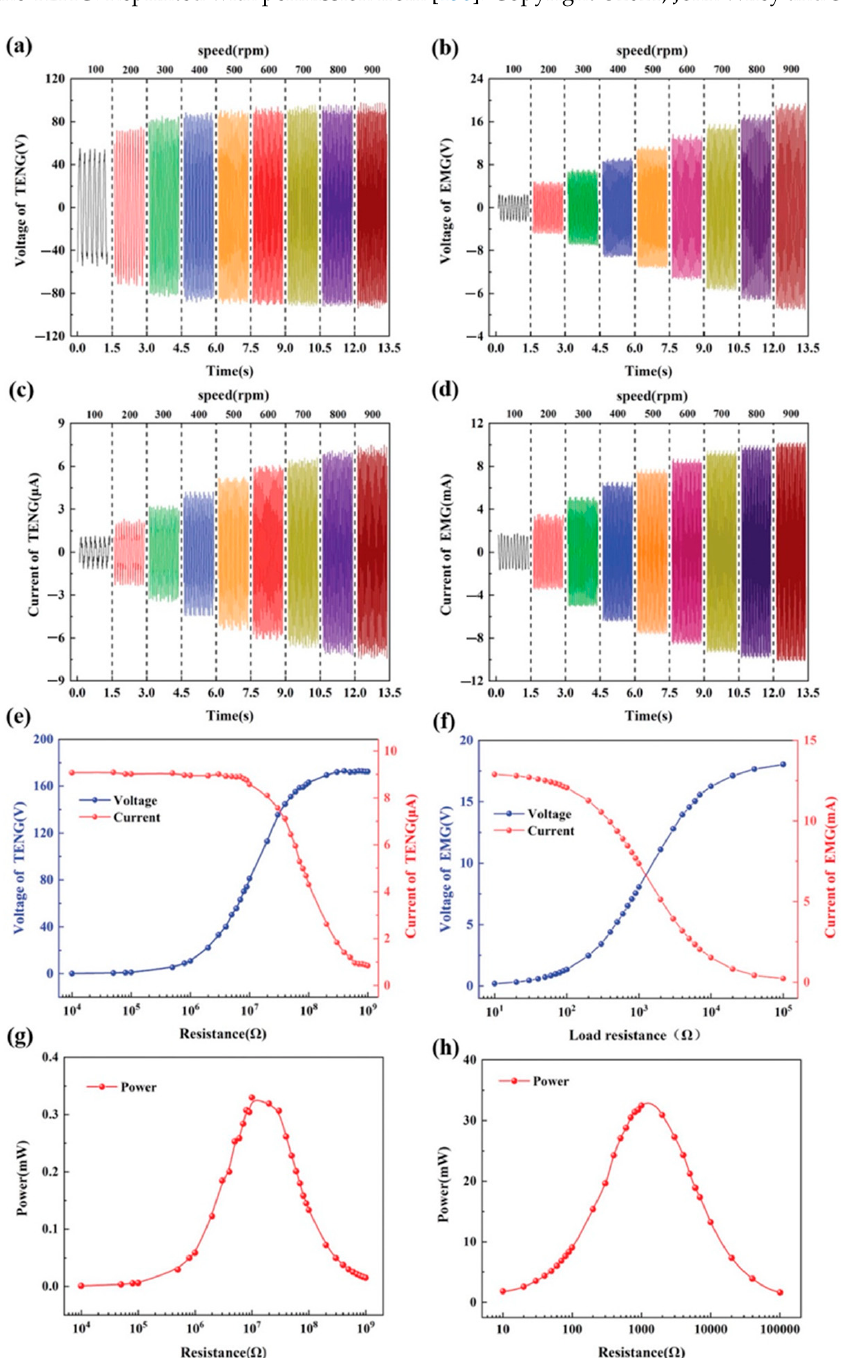
Figure 8. The output response of the TEHG was reported by Zhao et al. [156]. ( a , b ) The output open- circuit voltage of the TENG and EMG under several rotation speeds. ( c , d ) The output short-circuits current under several rotation speeds. ( e , f ) The output voltages and currents of the TENG and EMG as a function of external load resistance at a rotation speed of 400 rm. ( g , h ) The average output power of the TENG and EMG as a function of external load resistance at a rotation speed of 400 rpm. Reprinted with permission from [156]. Copyright ©2021, John Wiley and Sons.